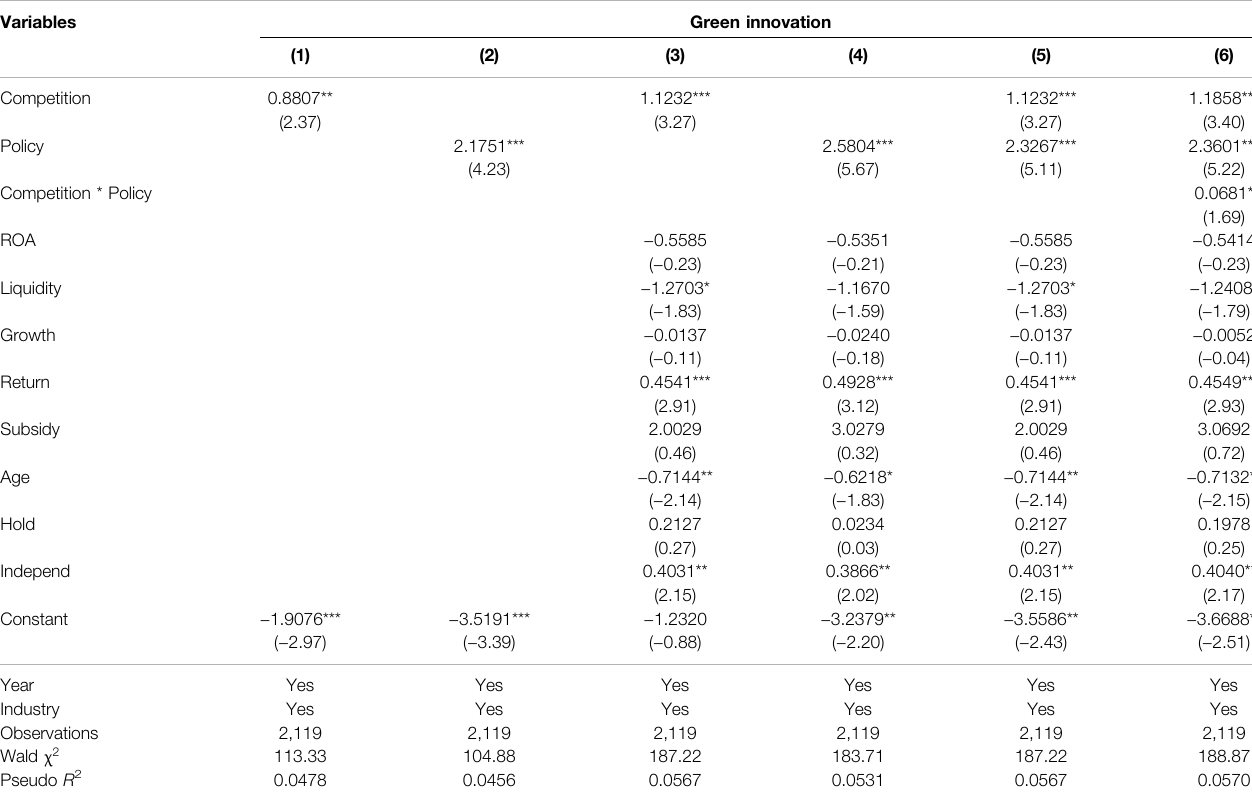
TABLE 4 | Baseline results of overall